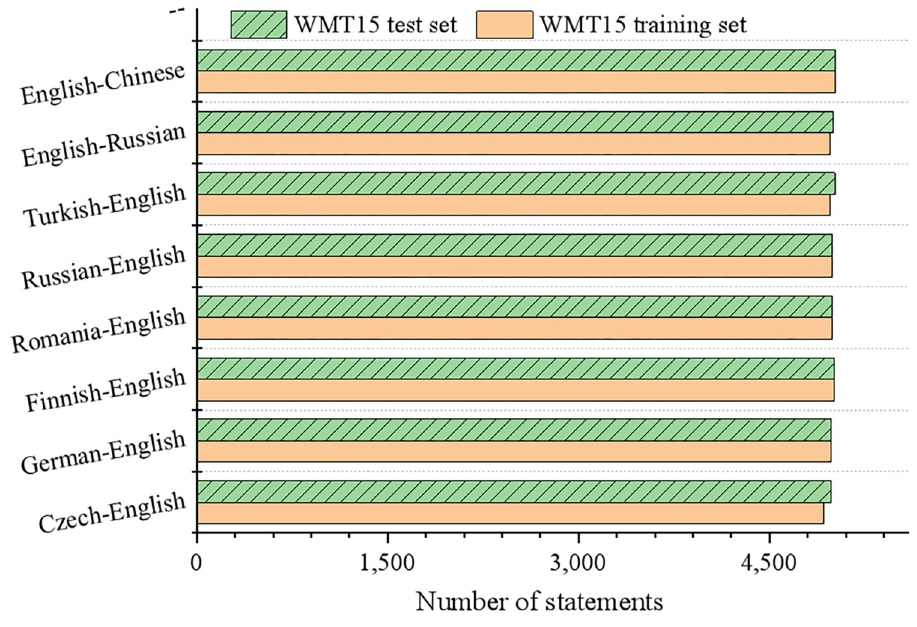
Fig 5. Statement details on news